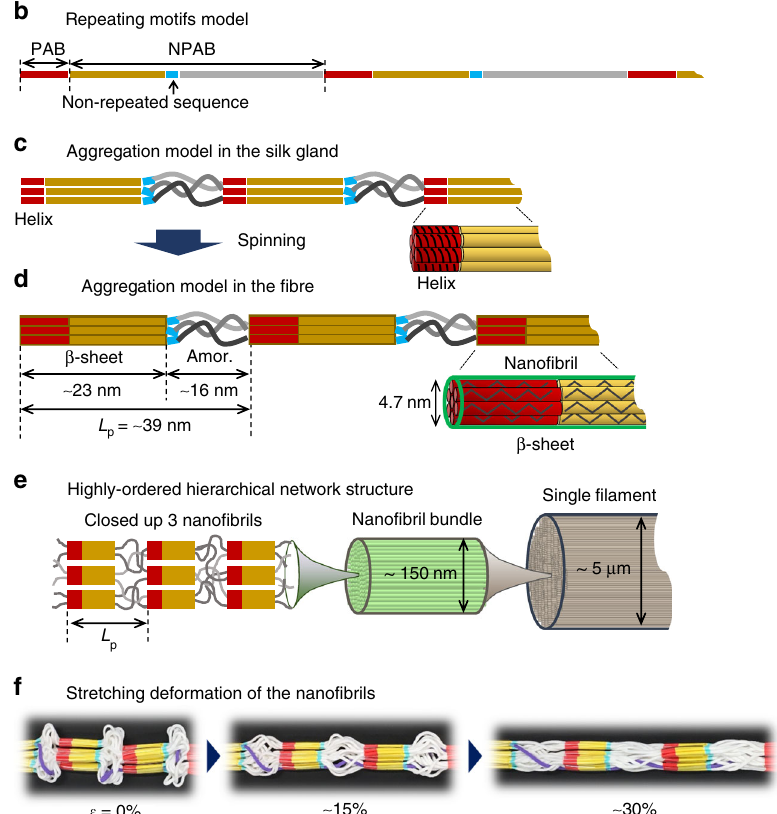
Fig. 6 Relationship between primary structure and hierarchical structure. a A representative sequence motif, corresponding to the top of Fig. 2, identi fi ed in the H-Fib protein of the E . variegata bagworm silk, and b the repeating model of the motifs. c Assumed aggregation model of the motifs in the silk gland, and d after spinning. In the silk gland, the PAB has a helical conformation, and the neighbouring helical PABs gather together to form the aggregation bundle (or nano fi bril) with 4.7 nm thickness and hexagonal packing, as shown in c . During the spinning process, the neighbouring NPAB sequences between the PAB and blue-coloured non-repeated sequences crystallise with β -sheet modi fi cation as shown in d . Simultaneously, the helical PAB bundle exhibited a stress- induced structural transition from helix to β -sheet crystals (as shown in d ). SAXS analysis revealed a well-developed nano fi bril bundle with a thickness of around 150 nm for a single fi lament, as shown in e . A stretching deformation model of the nano fi brils, during which the ordered repeating structure is maintained, is proposed in f . In situ X-ray analysis revealed that the deformations of the crystal and amorphous phases are reversible and irreversible modes,